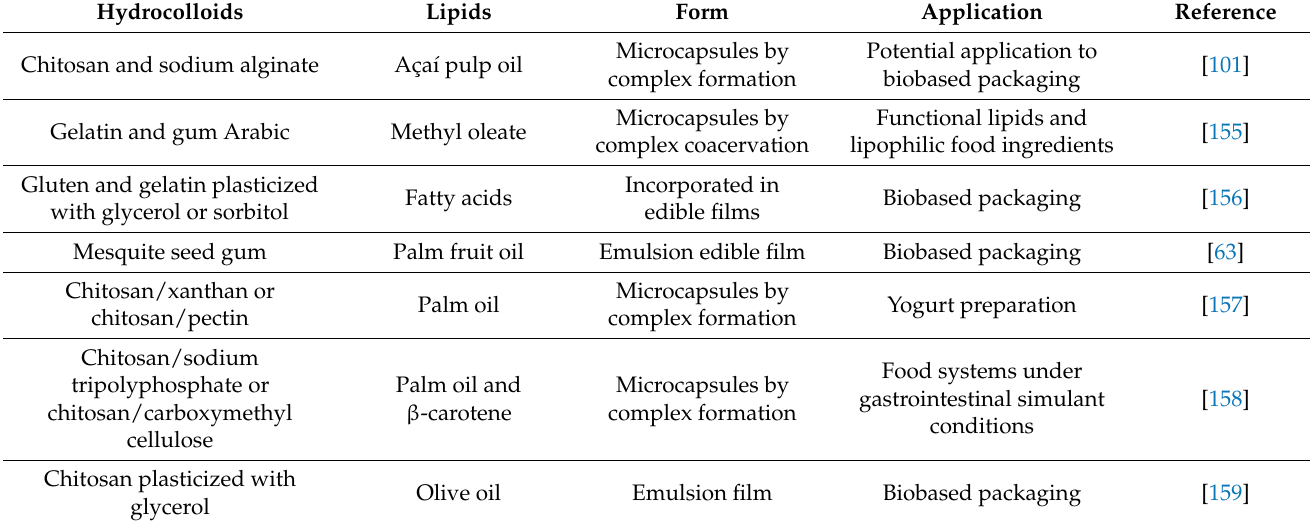
Table 5. Incorporation of lipids onto different hydrocolloid